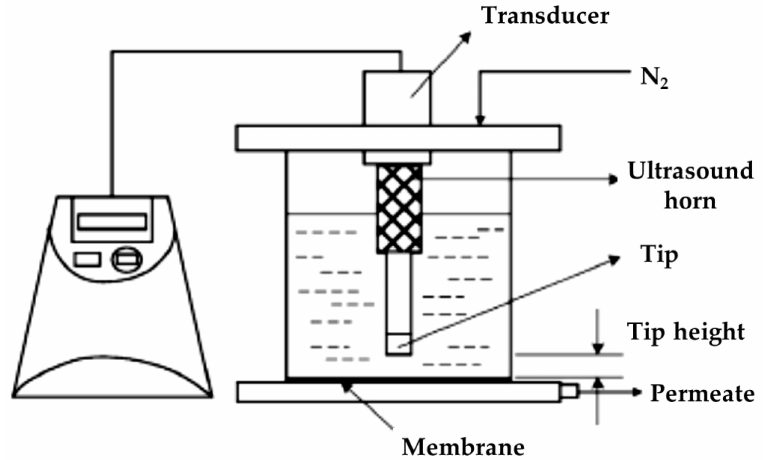
Figure 11. Experimental setup example for an ultrafiltration of suspended solutions with ultrasound. Figure has been adapted/reproduced from reference [116] with permission from